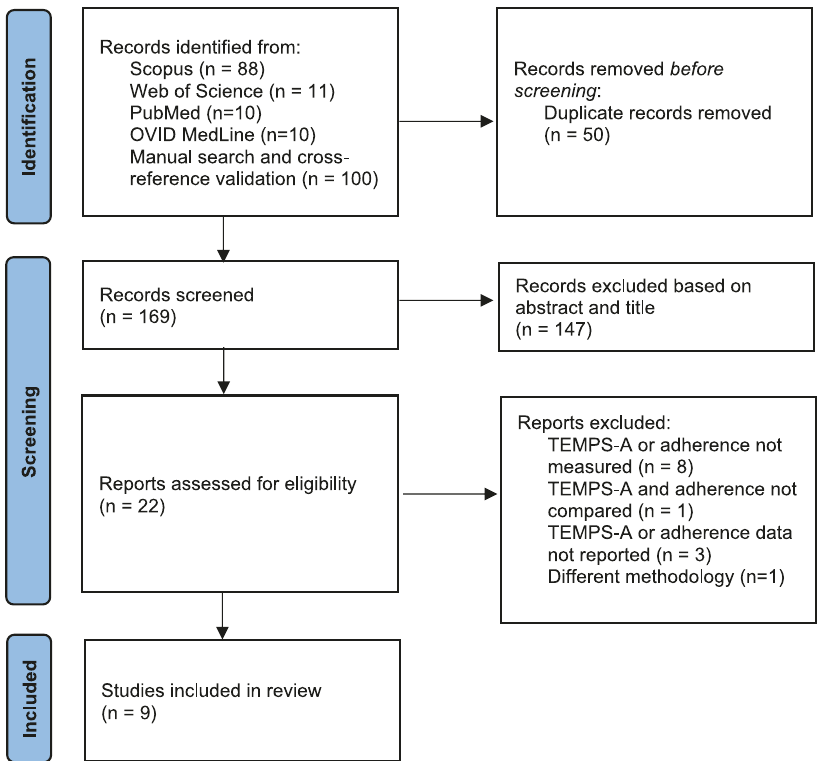
Fig. 1 PRISMA fl owchart. Flowchart of study identi fi cation and selection